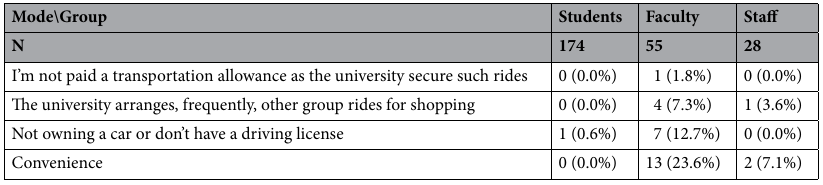
Table 9. Reasons for choosing private bus.